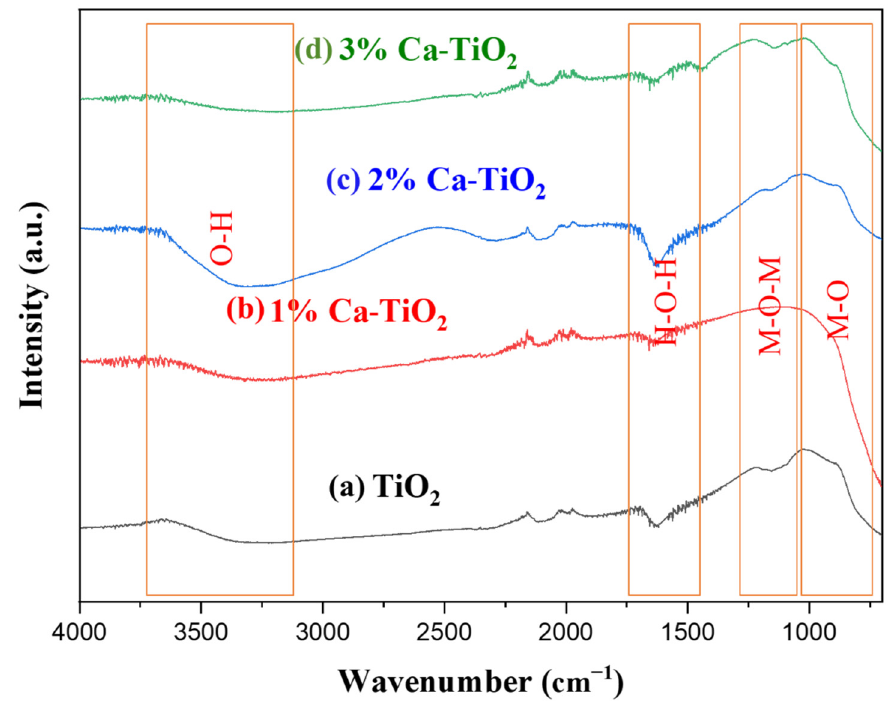
Figure 3. FTIR spectra of ( a ) pristine TiO 2 ( b – d ) 1–3% CaO loaded TiO 2.